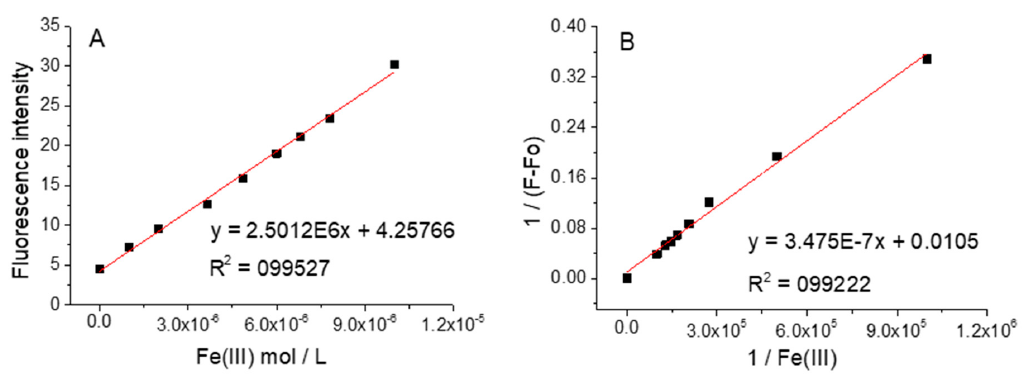
Figure 14. ( A ) Linear calibration curve of NI3 at different concentrations of Fe(III) cations (from 0 to 1 × 10 − 6 mol L − 1 ). ( B ) Benesi-Hildebrand plot of NI3 ( λ ex = 430 nm).